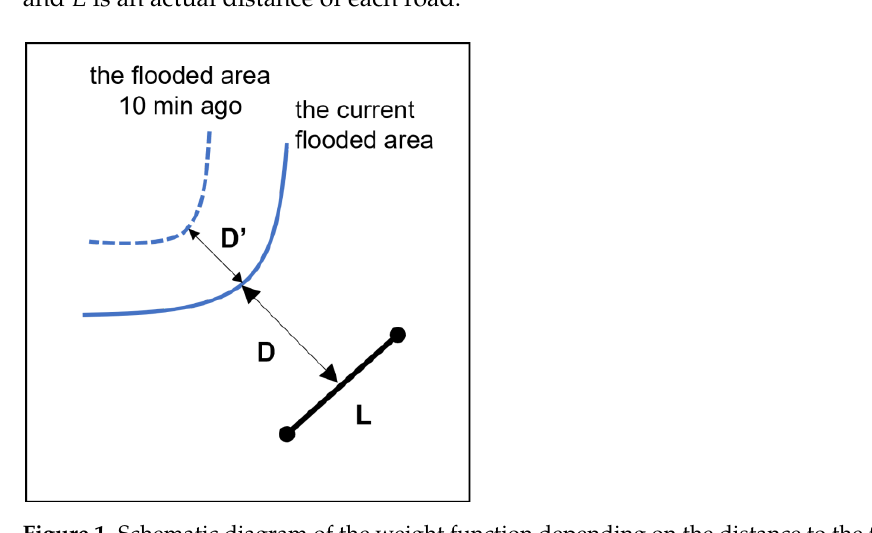
Figure 1. Schematic diagram of the weight function depending on the distance to the flooded